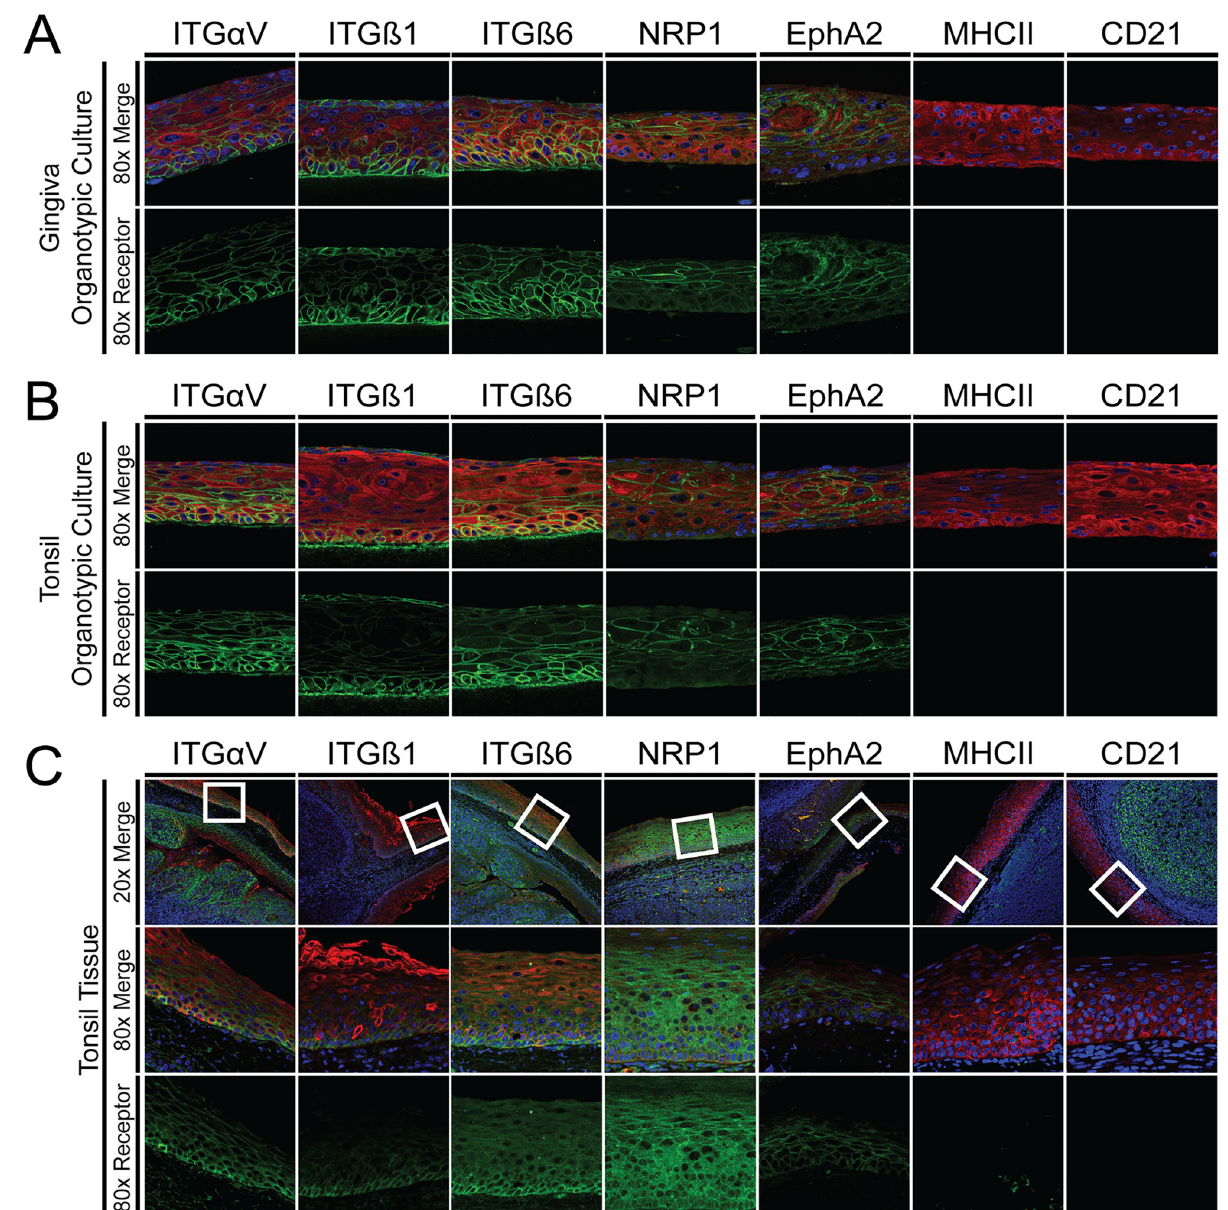
Fig 3. Expression of EBV epithelial cell receptors in gingiva and tonsil organotypic cultures. The expression of proteins proposed to serve as EBV receptors was identified by immunohistochemistry of paraffin embedded sections of gingiva organotypic cultures (A) , tonsil organotypic cultures (B) , and human tonsil tissue (C) . Images are displayed with the basolateral surface at the bottom. Hoechst (blue) was used to detect nuclei, and cytokeratin 5 (red) was used to identify keratinocytes. Proposed epithelial receptors were identified with specific antibodies (green). Micrographs are representative images from three biological replicates from two unique donor